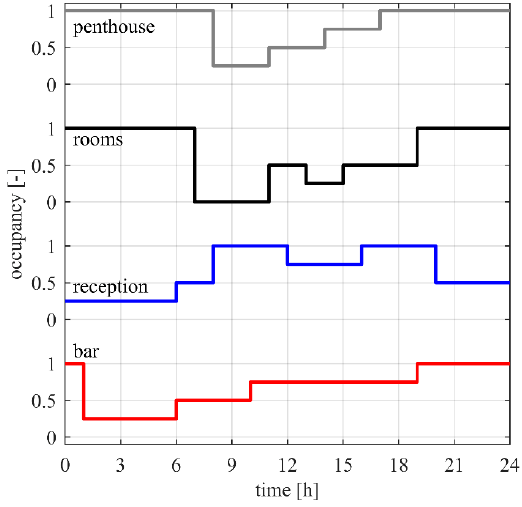
Figure 4. Daily occupancy profile of the thermal zone in the building.